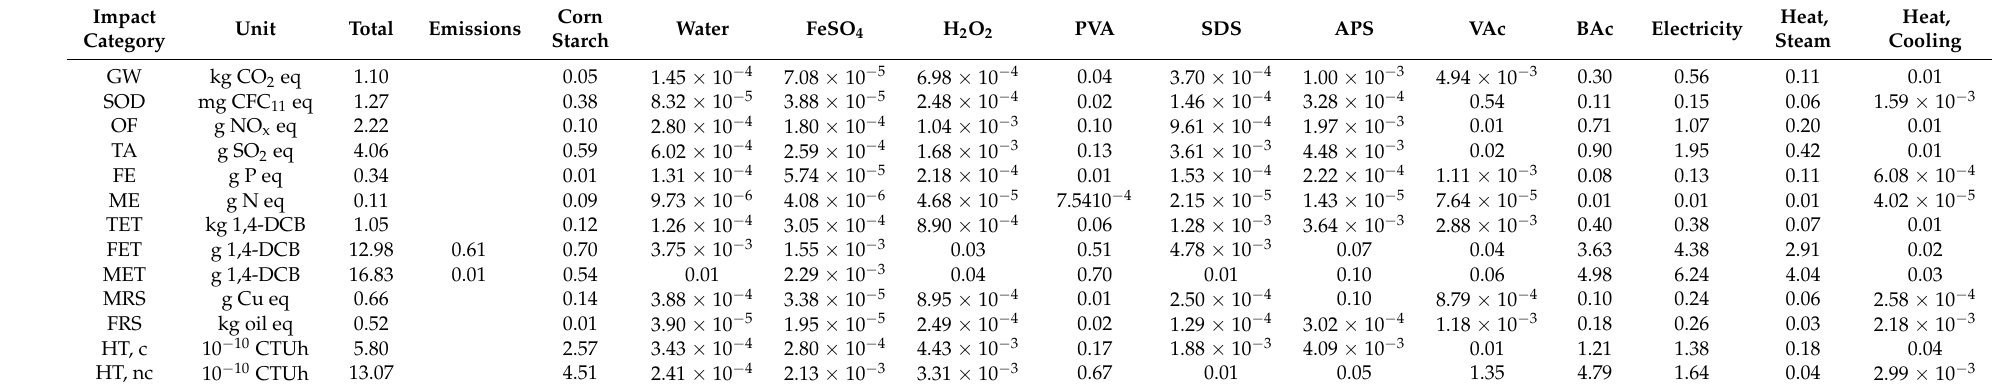
Table 8. Environmental characterization of starch bioadhesive oxidized with FeSO 4 and H 2 O 2 .